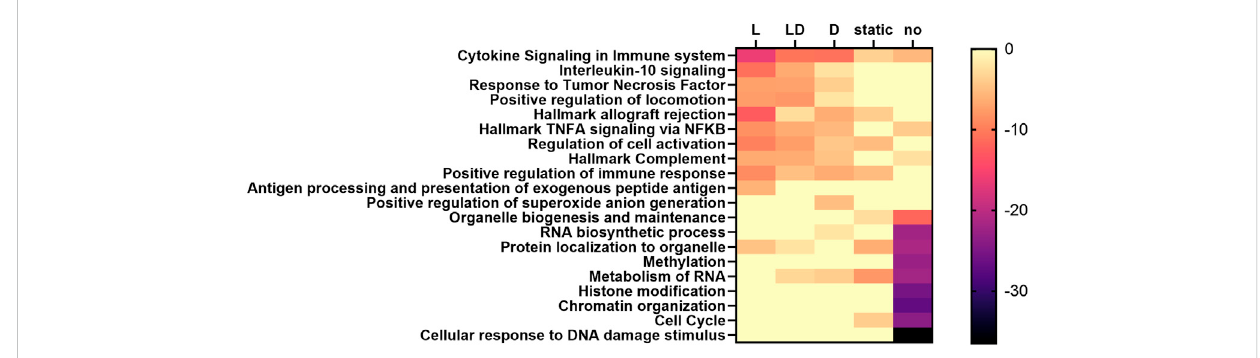
FIGURE 3 Heatmapoftheenrichment(log10-transformed p -values)ofselectedfunctionaltermsamonggeneswithdifferentASEcharacteristics,predictedby Metascape. L:setofgenesshowingcd-ASEdependingonLPS.D:setofgenesshowingcd-ASEdependingonDexamethasone.LD:setofgenesshowing cd-ASE depending on LPS + Dexamethasone. Static: set of genes exhibiting ASE across treatments but no cd-ASE. No: set of genes showing no signi fi cant